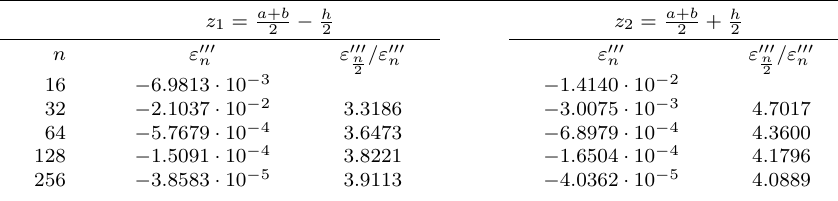
Table 2. Numerical results for ε (cid:48)(cid:48)(cid:48) n = S (cid:48)(cid:48)(cid:48) ( z i ) − y (cid:48)(cid:48)(cid:48) ( z i ), i = 1 , 2.